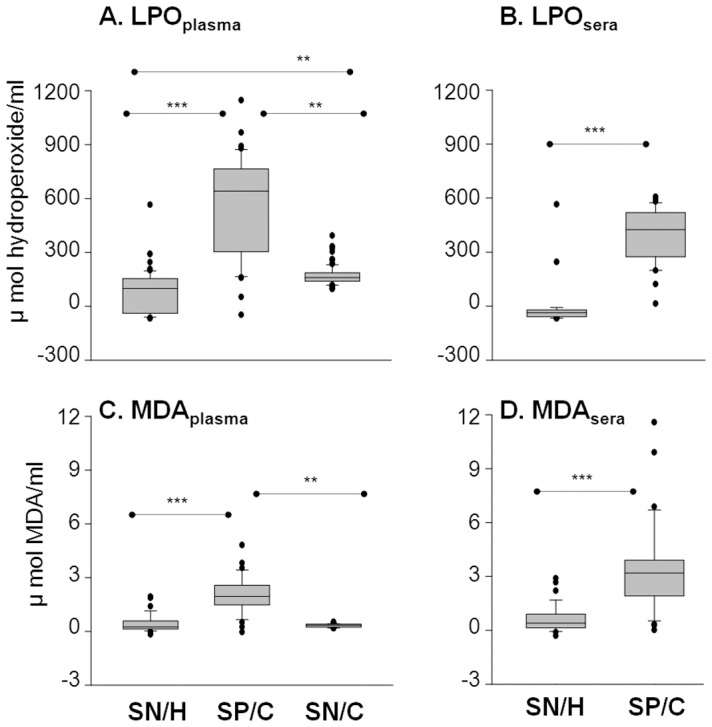
LPO and MDA are biomarkers of increased oxidative stress in chagasic subjects.The plasma (
A&C
) and sera (
B&D
) levels of lipid hydroperoxides (A&B) and malondialdehyde (C&D) were measured by spectrophotometry.